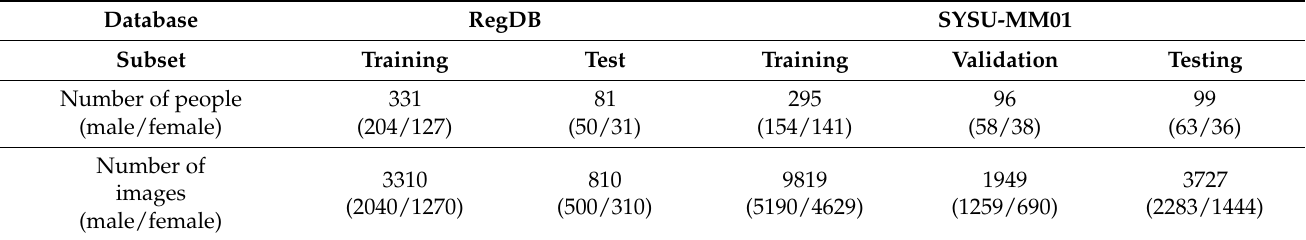
Figure 7. Example of the experiment database. ( a ) RegDB database and ( b ) SYSU-MM01 database. Table 7. Descriptions of the experimental